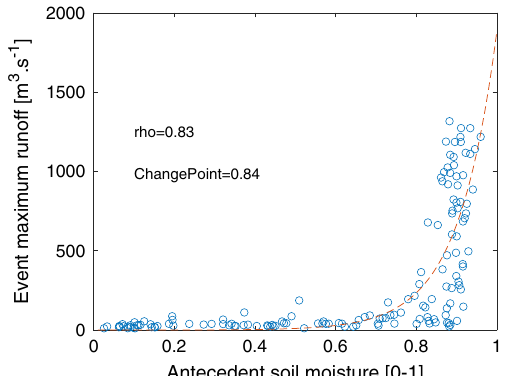
Figure 1. Example of the relationship between antecedent soil moisture and events maximum runoff (Sankarani River in Guinea, 22,102 km 2 ). The correlation between event maximum runoff and antecedent soil moisture is equal to 0.83 and the change point identified in antecedent soil moisture is equal to